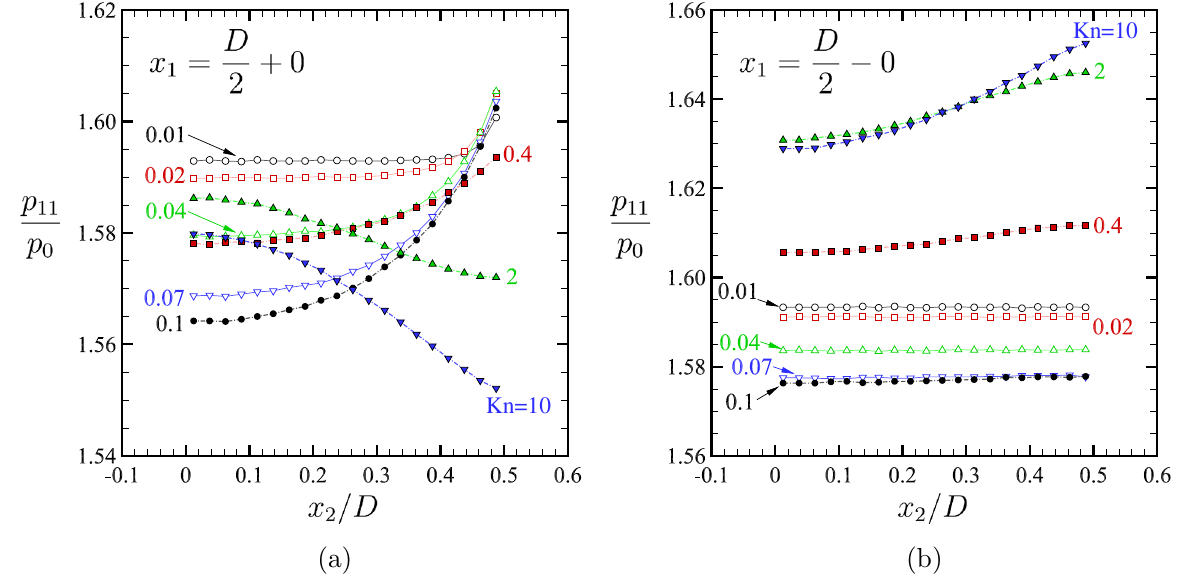
0 and 0 D / 2 x 2 < D / 2 , = ± ≤ 2 ( H / D 2 , L / D 1 ). ( a , b ) Profiles of p 11 along ( a ) x 1 0 and D / 2 = = = = + 0.1 and empty symbols for Kn < 0.1 . ≥